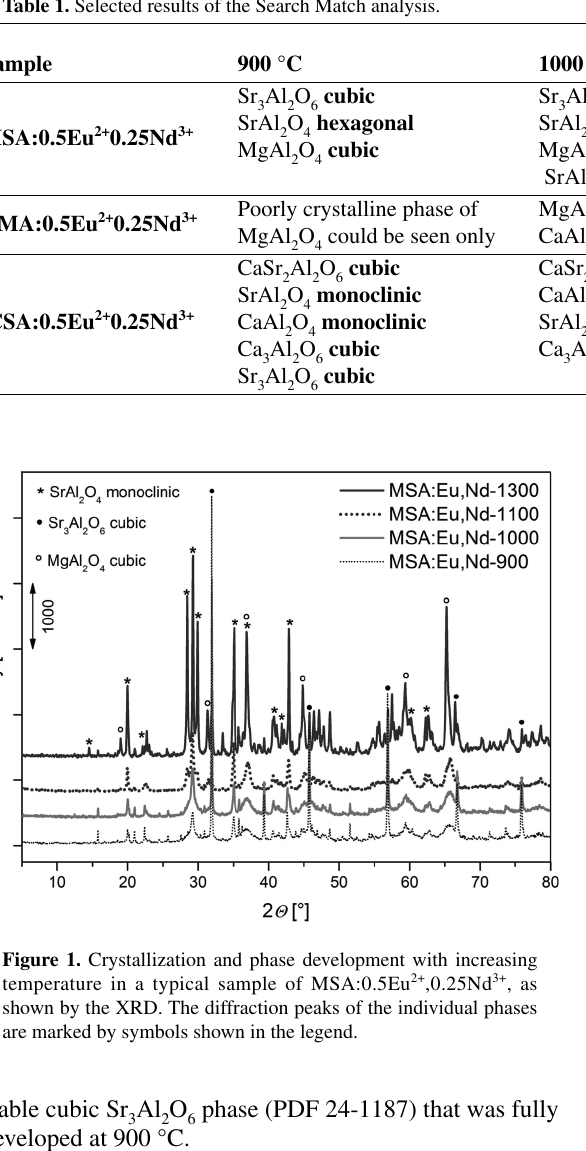
Figure 2. Crystallization and phase development with increasing temperature in a typical sample of CSA:0.5Eu 2+ ,0.25Nd 3+ , as shown by the XRD. The diffraction peaks of the individual phases are marked by symbols shown in the legend. The legend of the cur- ves is ordered by